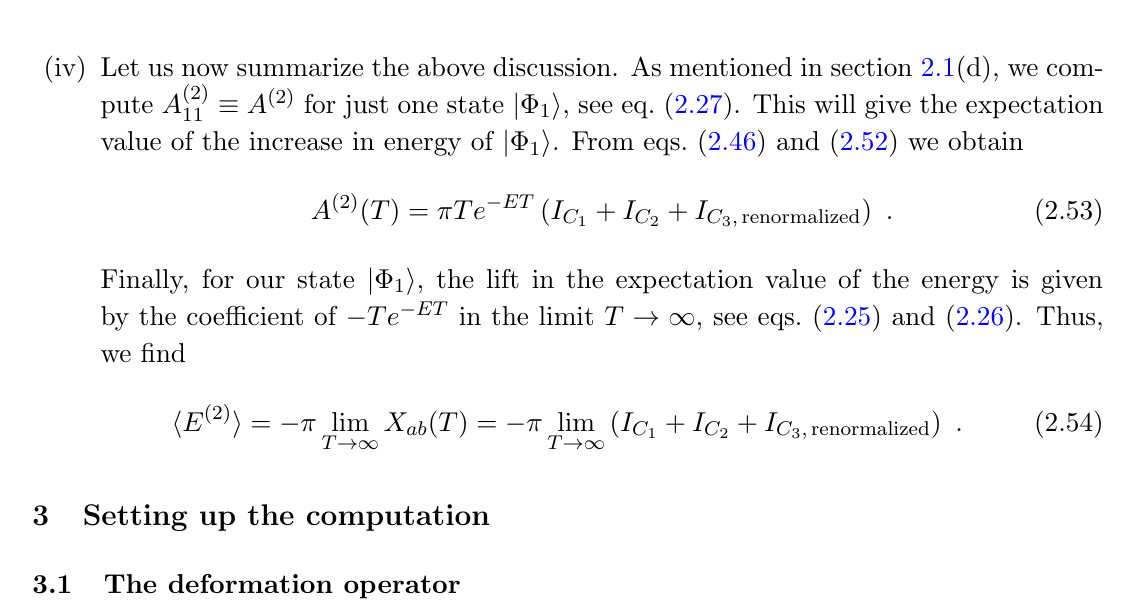
Figure 3 . Here we show the locations of the three boundary contour integrals, I C given in equations (2.48), (2.49), and (2.50)